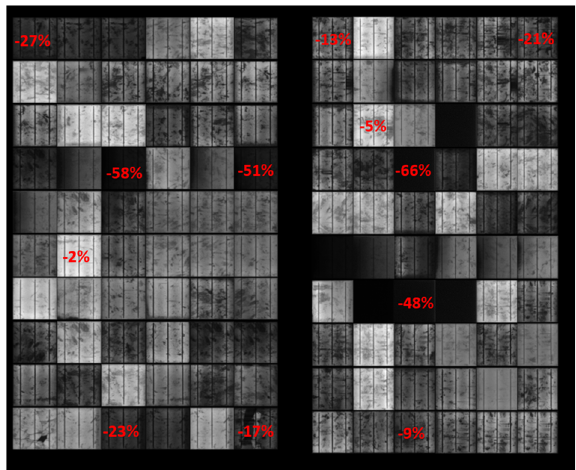
Fig. 6 EL images after PID are completed for two different PV modules. The power loss labelled in red was estimated under the standard test